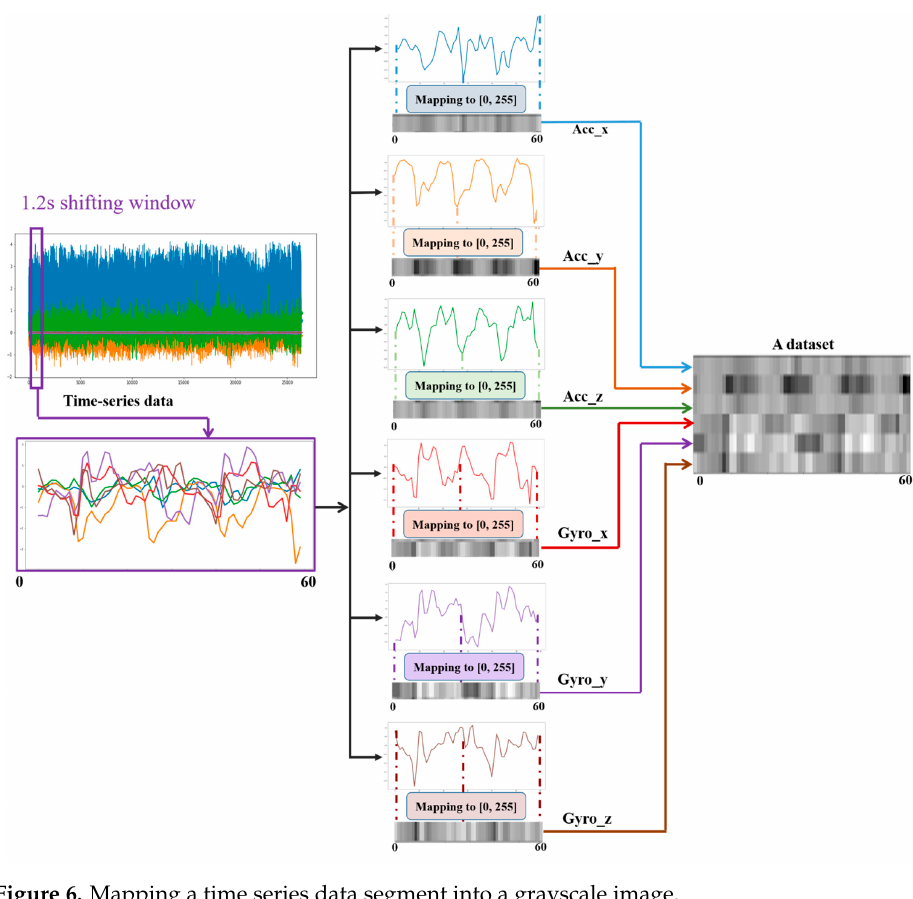
Figure 6. Mapping a time series data segment into a grayscale image.